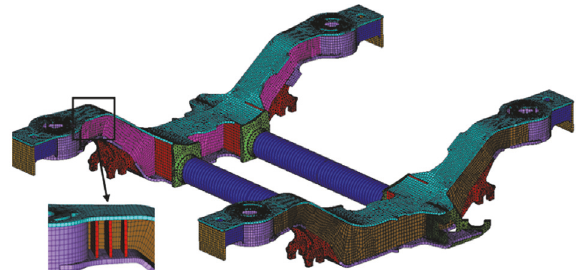
Figure 17: Stiffened plates of bogie.